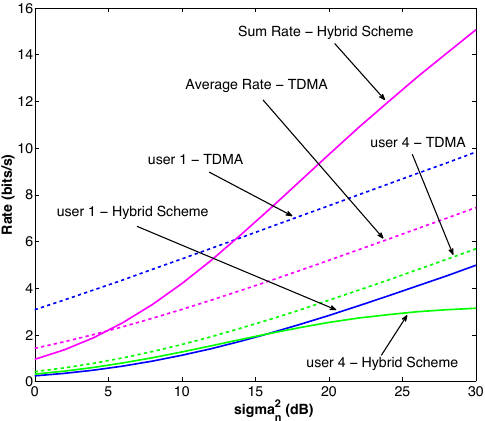
Figure 10. Rate Performance compared to TDMA (SISO BC). For SNR values >0dB, the hybrid schemes outperforms TDMA.